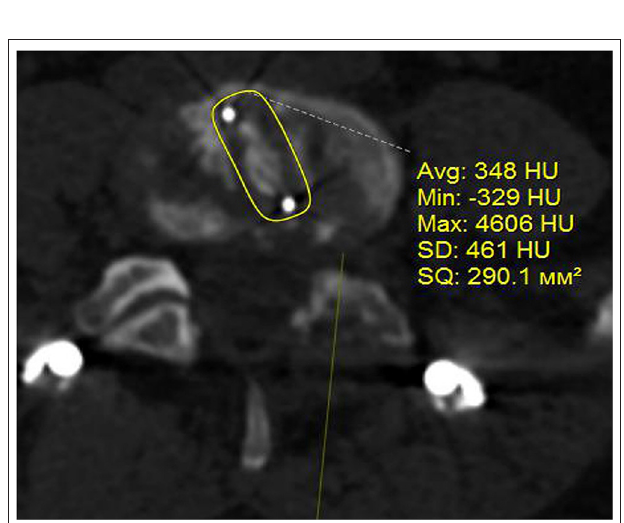
FIGURE 2 | Cage used for TLIF, postoperative CT image in axial